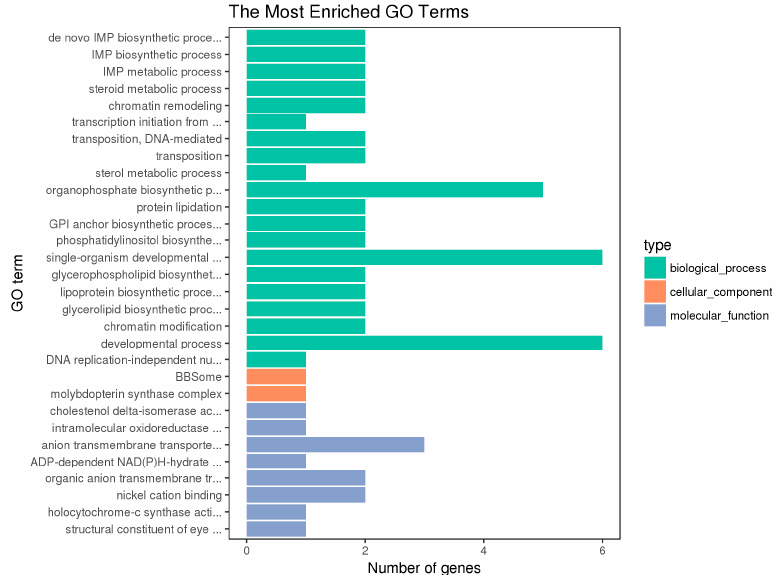
Figure 4. GO Enrichment of the Hypothalamic DEGs. The vertical coordinate is the enriched GO term, and the horizontal coordinate is the number of di ff erential genes in the term. Di ff erent colors are used to distinguish biological processes, cell components, and molecular functions (the same below).